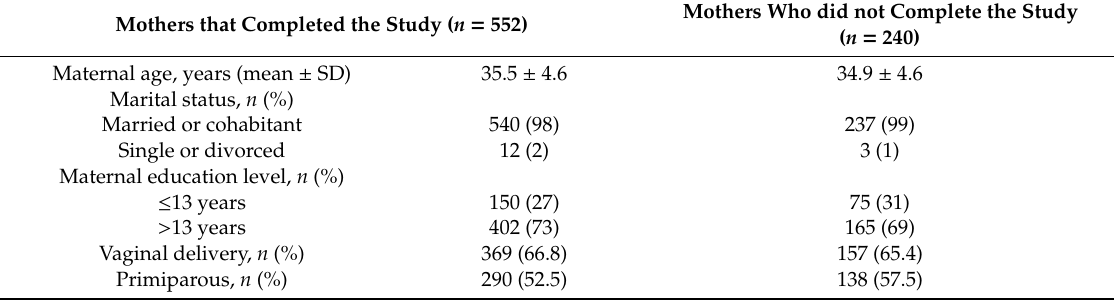
Table 1. Basic characteristics of the mother-infant pairs that completed ( n = 552) and that not completed (240) the